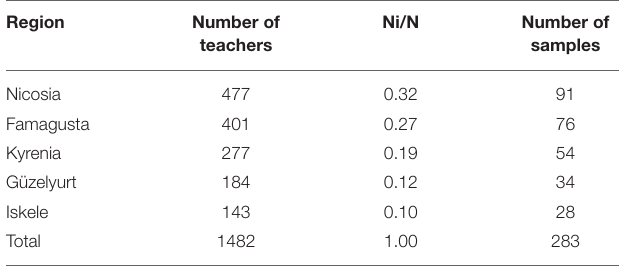
TABLE 2 | Distribution of the demographic characteristics of school